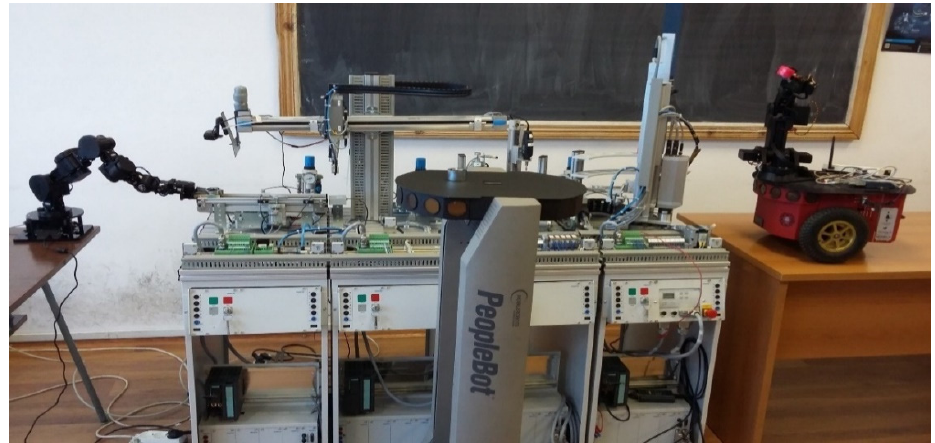
Figure 2. Work-pieces; ARS Pioneer 3-DX; RM Pioneer 5-Degrees of Freedom (DOF); ARS PeopleBot; RM Cyton 1500.